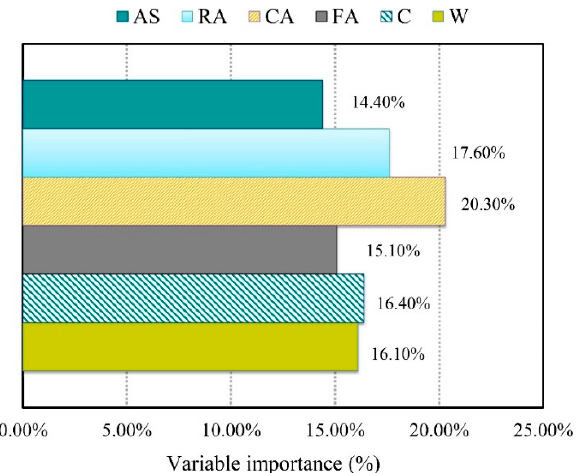
Figure 12. Variable importance of the developed Fuzzy GMDH-HOA model.